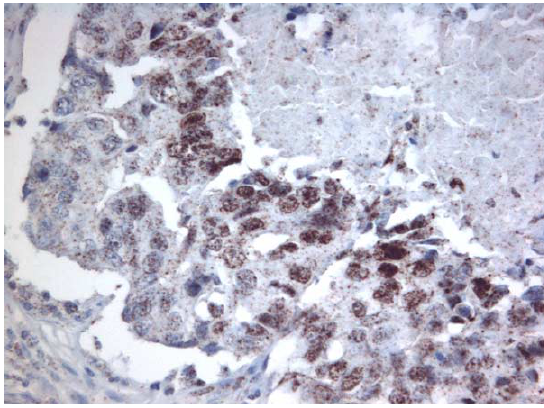
Fig. 1. Example of perinecrotic HIF-1 α immunohistochemical stain- ing in an invasive breast cancer.